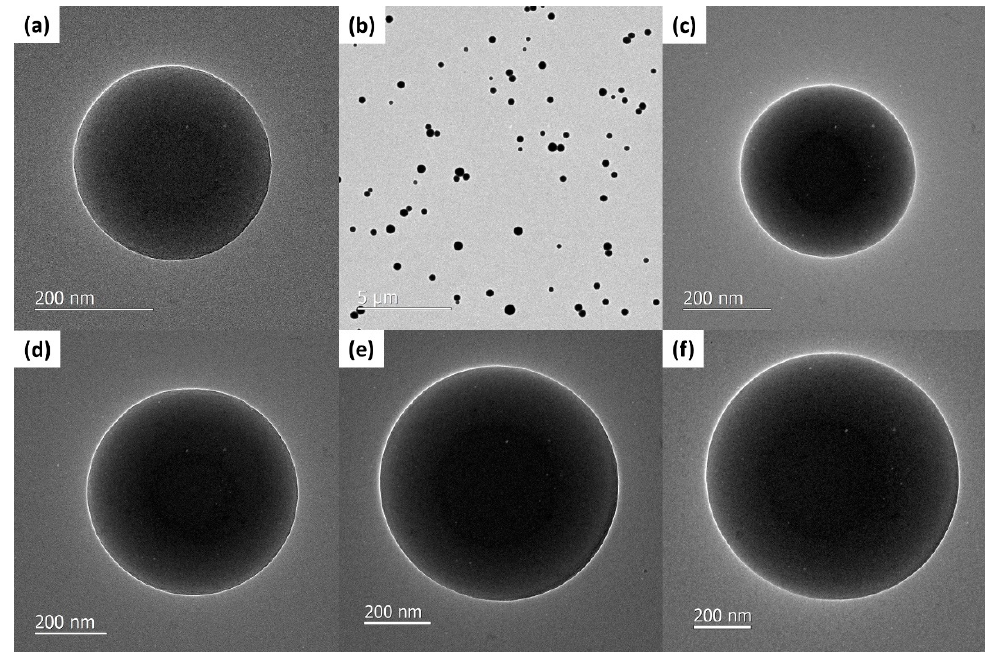
Figure 3. ( a ) TEM image of a CSNP from a P 0.5 B 2 reaction. ( b ) low magnification TEM image from the P 0.5 B 1 reaction. ( c – f ) CSNP images from P 1 B 2 , P 2 B 2 , P 4 B 2 , and P 6 B 2 reactions, respectively.